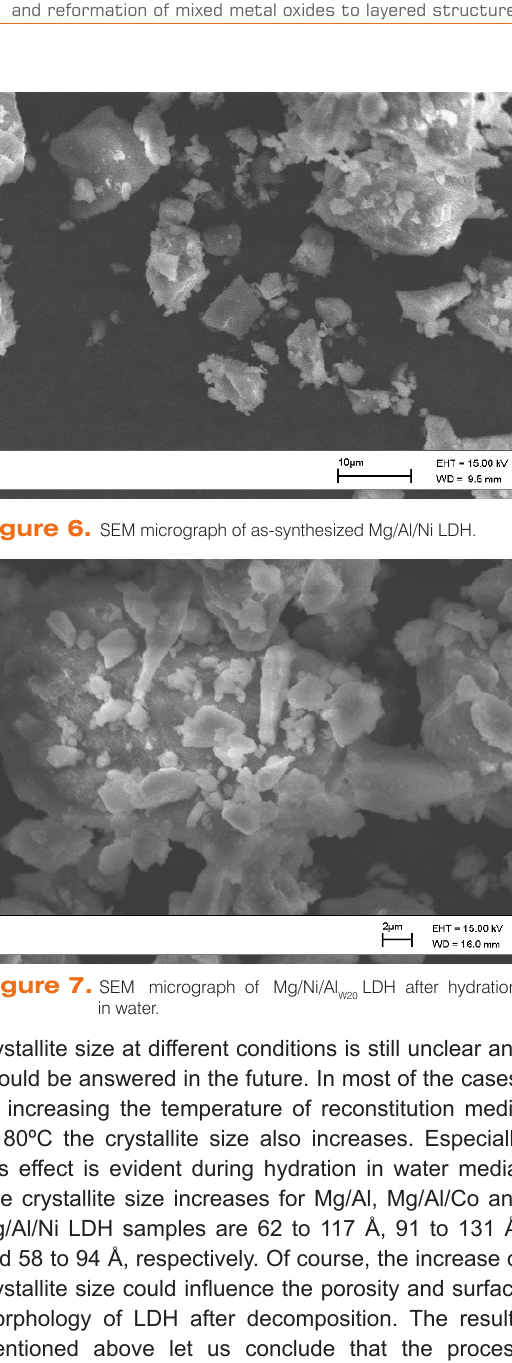
Figure 5. XRD patterns of reconstituted layered double